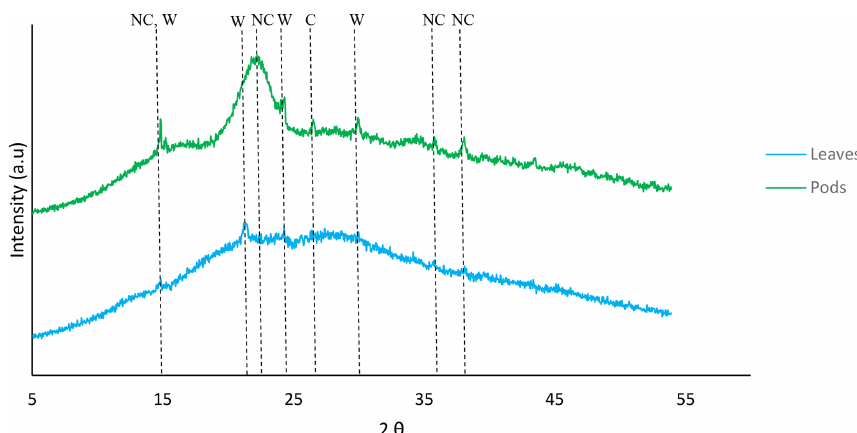
Figure 3. X-ray diffractogram of the leaves and pods of Delonix regia . NC refers to native cellulose ((C 6 H 12 O 6 ) x ), W refers to whewellite (cid:113) (cid:113) (C 2 CaO 4 H 2 O / CaC 2 O 4 H 2 O), and C refers to